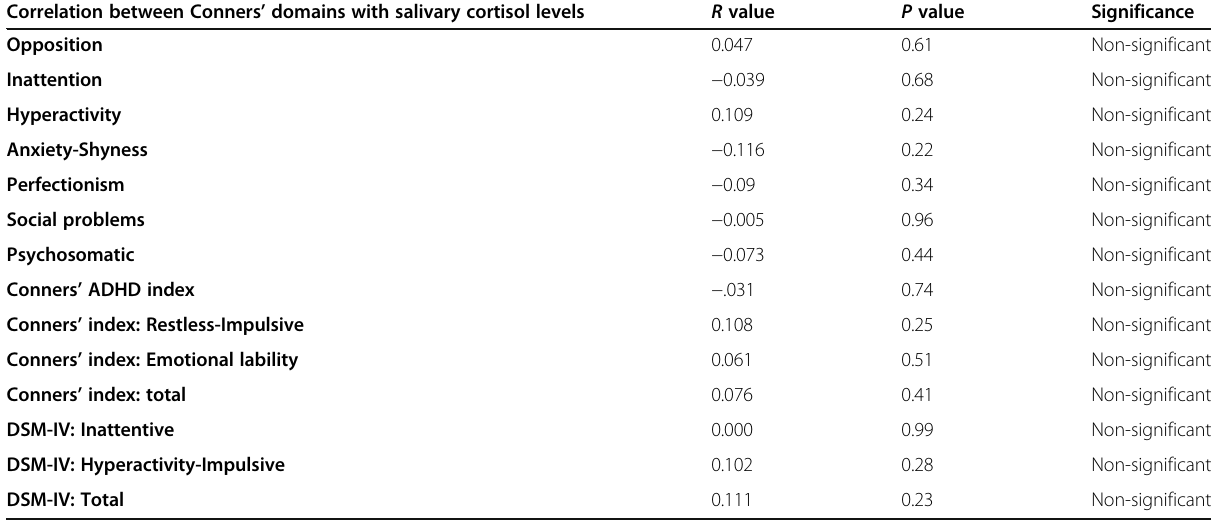
Table 2 Correlation between salivary cortisol levels and scores of Conner ’ s Parent Rating Scale in the ADHD group Correlation between Conners ’ domains with salivary cortisol levels R